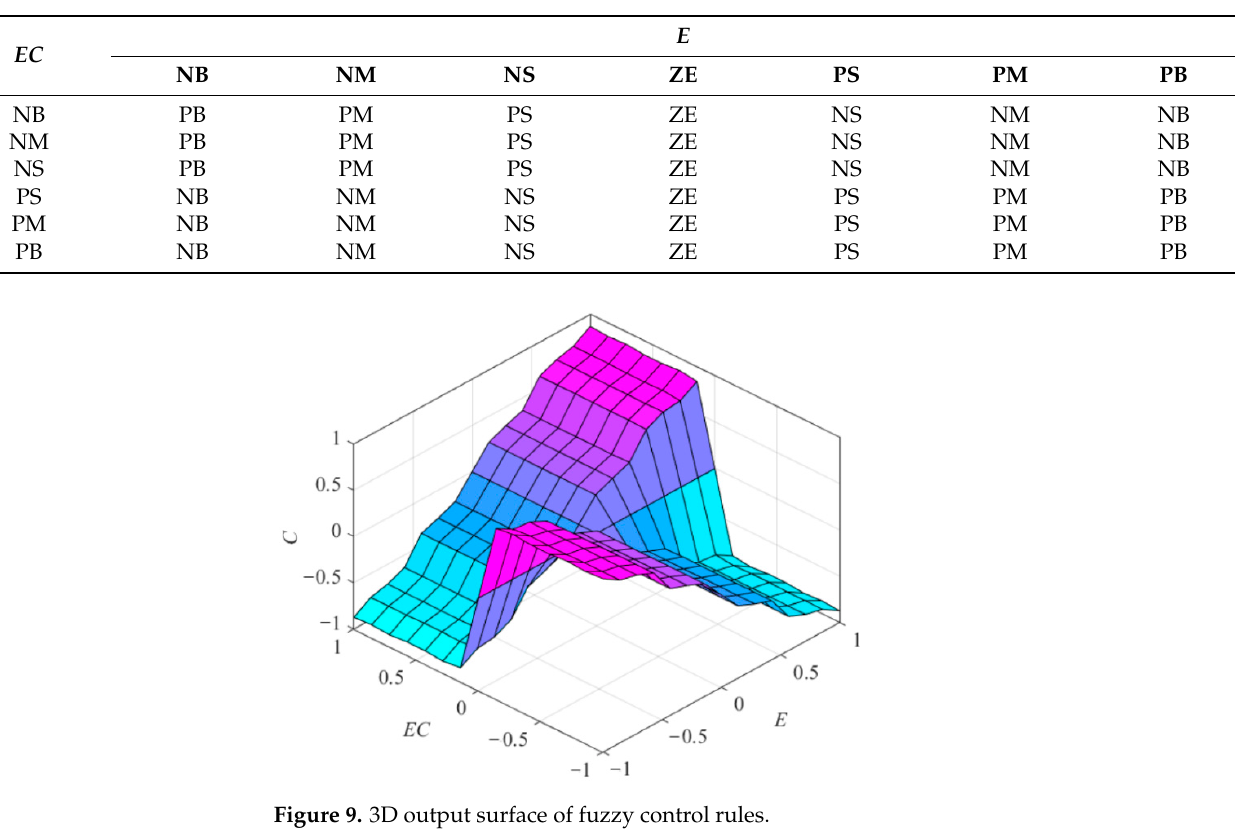
Table 2. Fuzzy control rules.